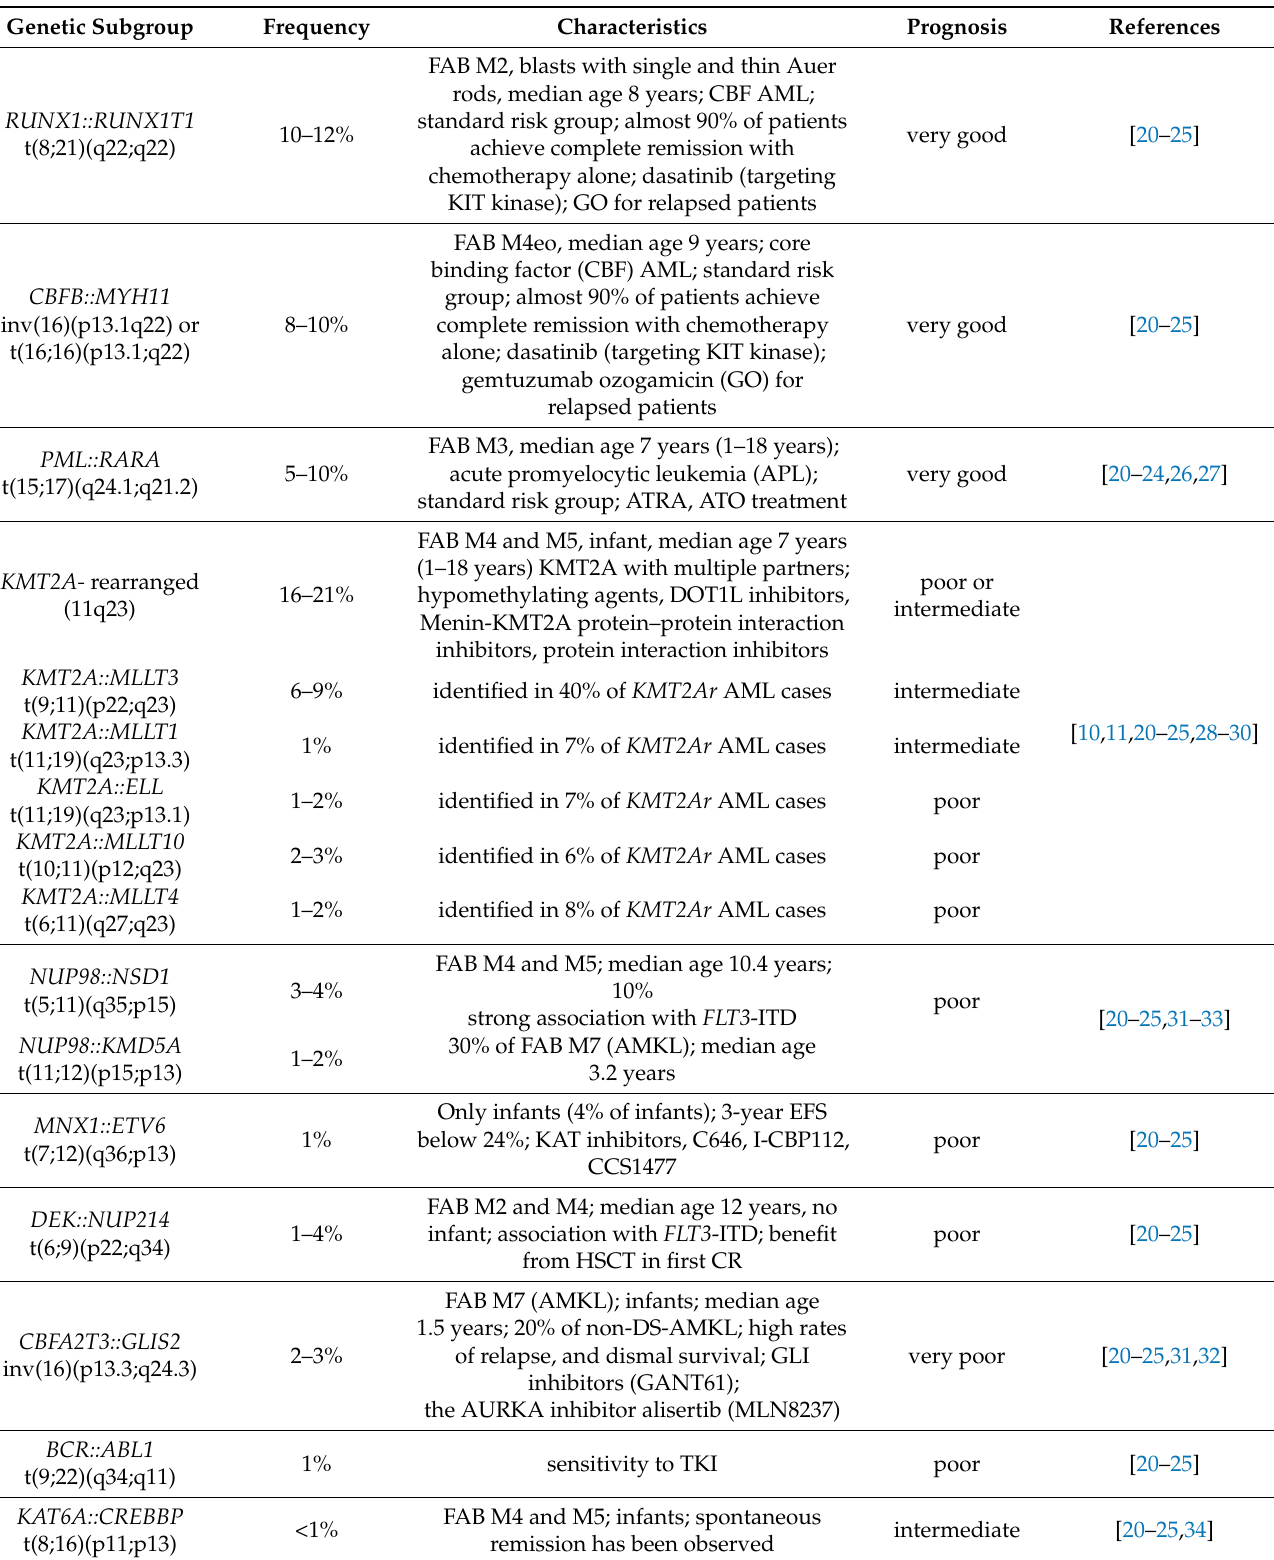
Table 2. Genetic subgroups of acute myeloid leukemia in